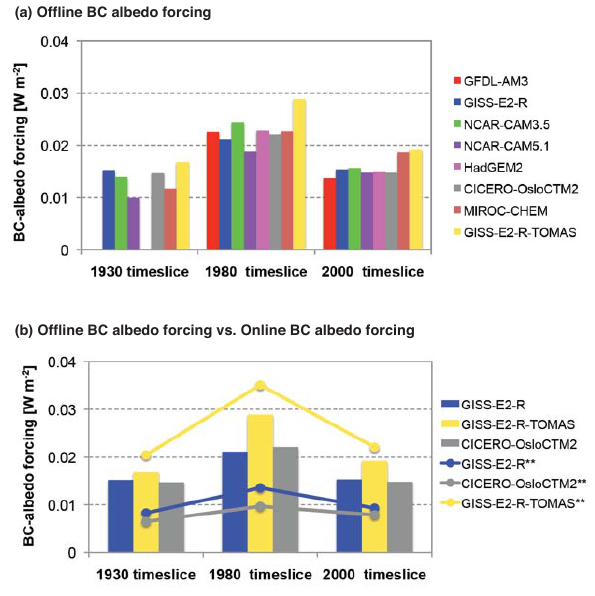
Fig. 15. Global annual average of (a) offline BC albedo forcing from 8 ACCMIP models and (b) comparison of the offline forcing to on- line BC albedo forcing. Note that the offline BC albedo forcing is computed in the offline land and sea-ice models (NCAR CLM4 and CICE4, see Sect. 3 for more details), and the online BC albedo forc- ing is computed in its own model. In (b) , the offline BC albedo forc- ing is shown in the bar plot and the online forcing, in the line plot.